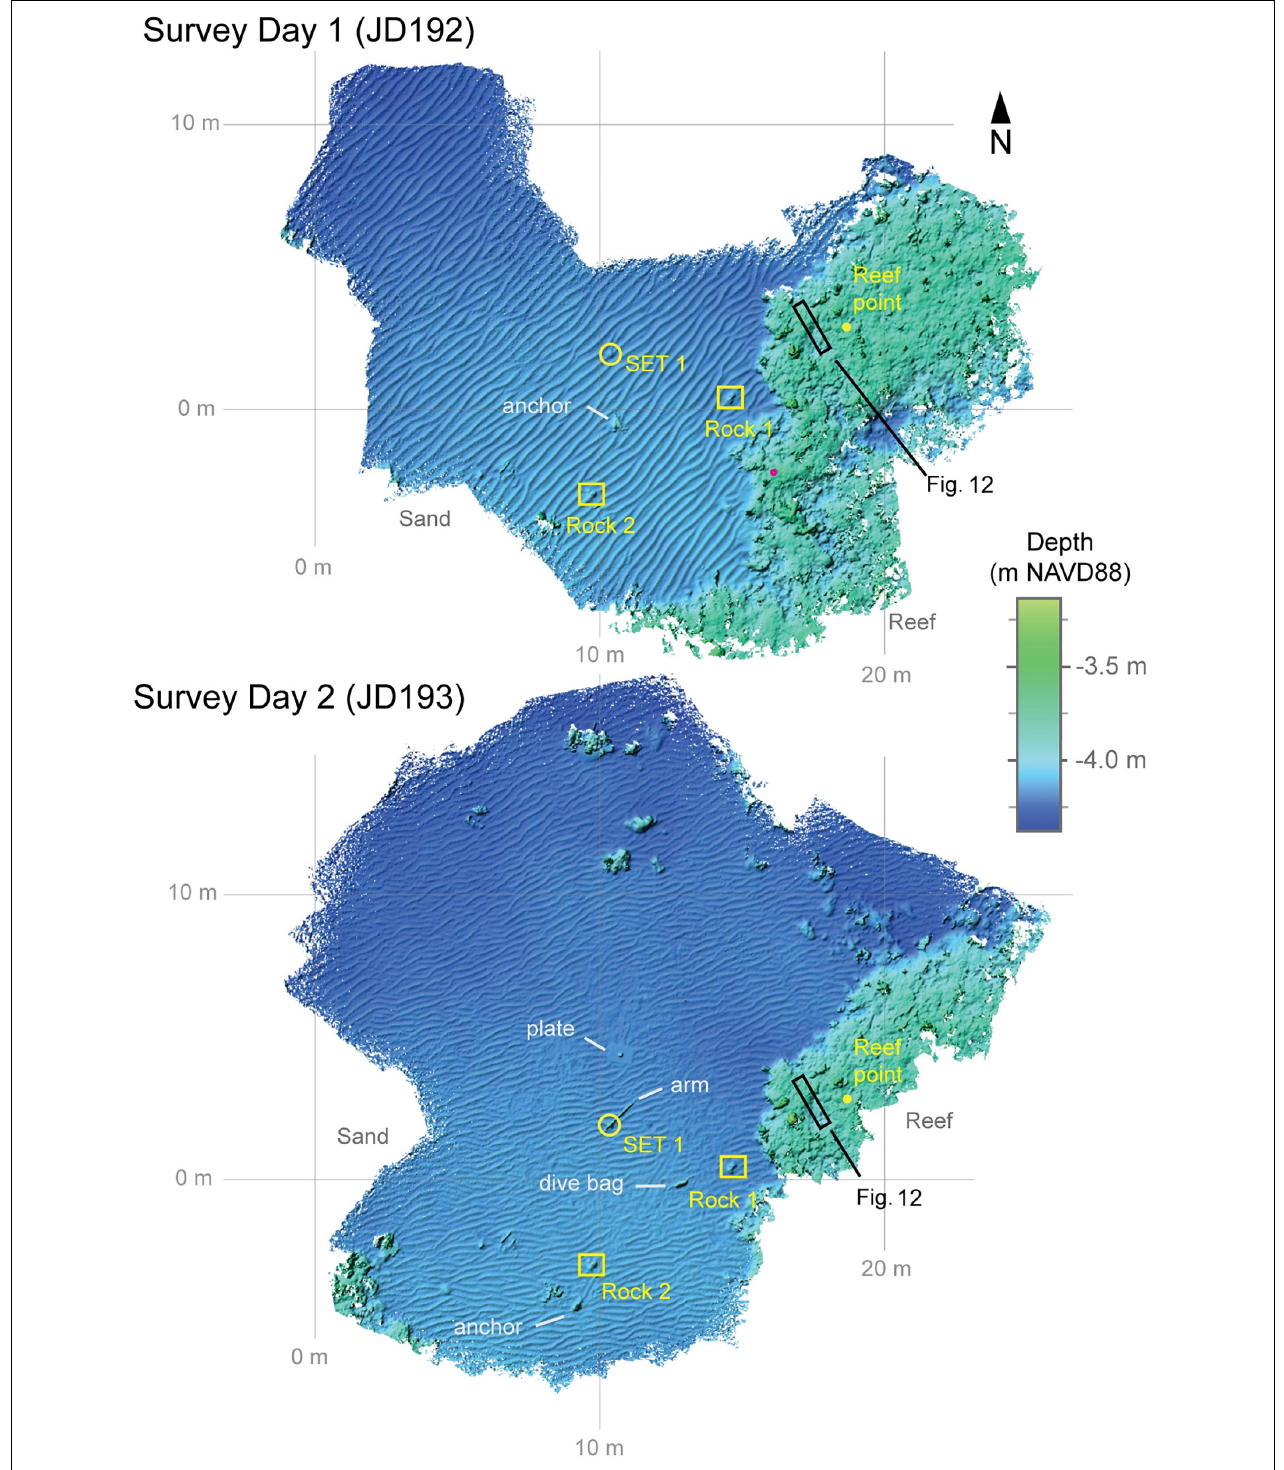
FIGURE 8 | Mapped bathymetry obtained from several survey passes of the Surface Elevation Table (SET) station 1 site with the SQUID-5 system. Survey data from 2 days were collected and processed independently with our Structure-from-Motion (SfM) workflow. Shaded relief bathymetry is shown for the DSMs with spatial resolutions of 3.9 and 4.1 mm, respectively. The wavelength (approximately 0.3–0.5 m) and amplitude (approximately 0.02–0.04 m) of the sand ripples were similar between surveys; however, an approximately 40 ◦ change in orientation and complexity increase are readily observed. Locations of several features used for the analyses are labeled. Field crews were conducting SET measurements during the second survey day, as shown by the dive bag, anchor, and measurement tool arm on the SET site.